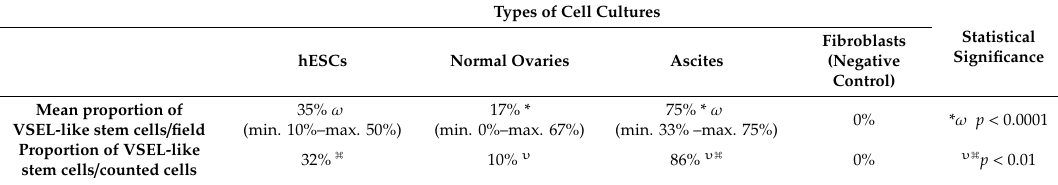
Figure 1. VSEL-like stem cells with diameters of up to 5 μ m in cell cultures as individual cells (arrows) or cell clusters (asterisks). ( A – F ) Human embryonic stem cells (hESCs), and ( G – I ) normal ovary cells. Inverted microscope (Hoffman illumination). Red bar: 10 μ m for A–C, G–I; 50 μ m for D– F. Table 1. Proportion of VSEL-like stem cells in di ff erent cell cultures prior to MACS-sorting. Types of Cell